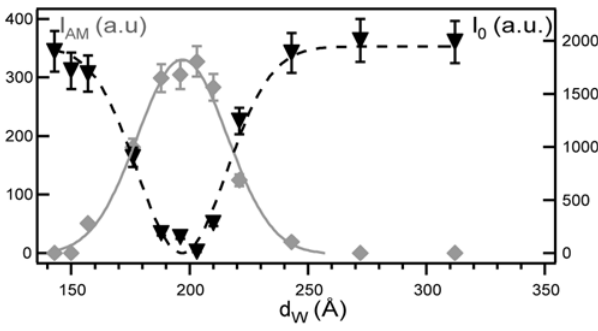
Figure 5. Determination of the best interaction condition : Evolution of bound MexA with the distance between bilayers. Variation of fluorescence intensities I 0 and I AM of free MexA (black triangles down) and MexA bound to OprM trimers(grey diamonds), respectively. Since fluorescence intensity is proportional to a MexA species population, we observe a shift in population from the free to the OprM-bound MexA species as the spacing distance approaches d W =200 A˚. At d W < 200 A˚, almost all MexA proteins are bound to OprM trimers. These data are fitted by two gaussian curves. PLoS ONE |